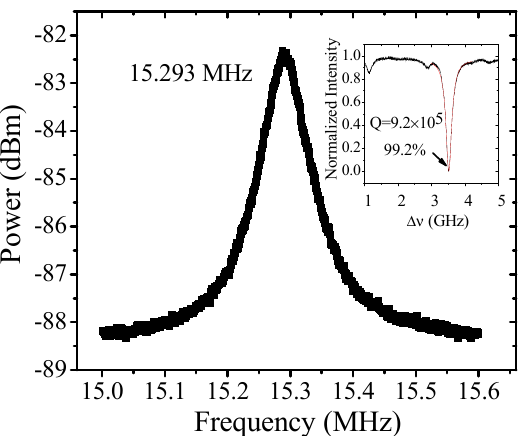
Figure 2. Mechanical spectra of a hollow micro-bubble resonator (MBR) (diameter 168 μ m and wall thickness 5–6 μ m) at 6.5 mW laser pump. Inset: The transmission spectrum of the optical resonant mode. The quality factor of the mode is 9.2 × 10 5 measured at low laser power.